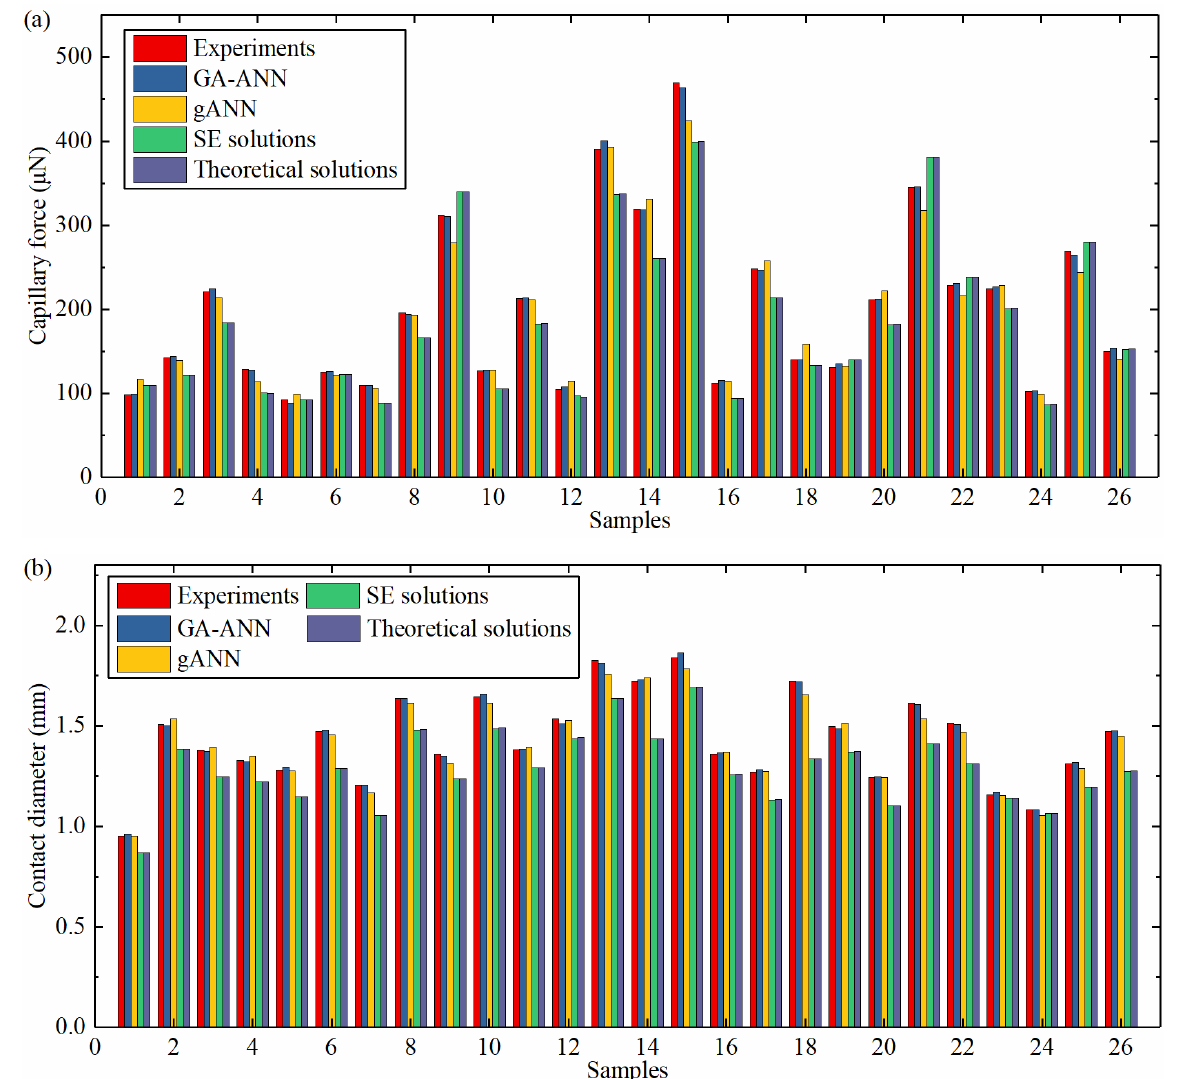
Figure 9. Comparison of prediction results: ( a ) capillary force and ( b ) contact diameter.